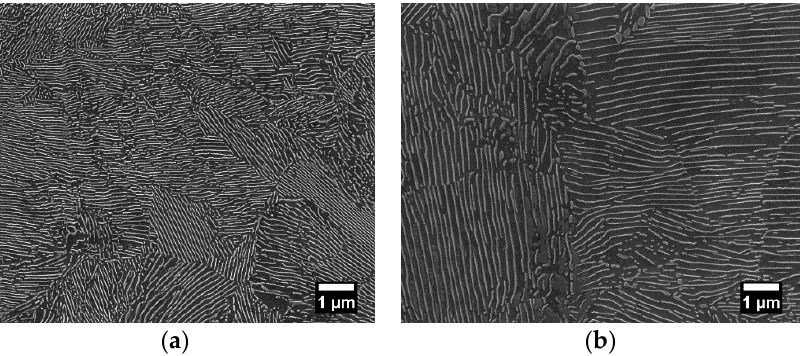
Figure 2. FE-SEM images showing fine and coarse lamellar pearlite microstructures of the AISI 1080 steel patented at, respectively, ( a ) 540 °C and ( b ) 640 °C.